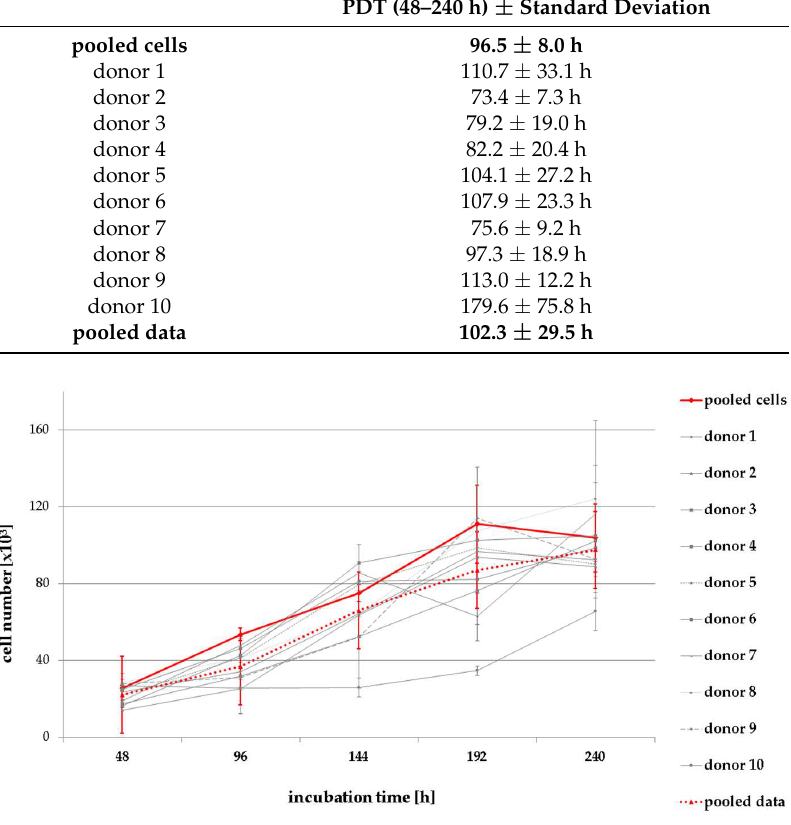
Figure A1. Donor-specific differences in the growth rate of ADSCs, isolated from ten different donors: comparison of pooled cells and pooled data. Results are illustrated as mean ± standard deviation (SD, n = 2).